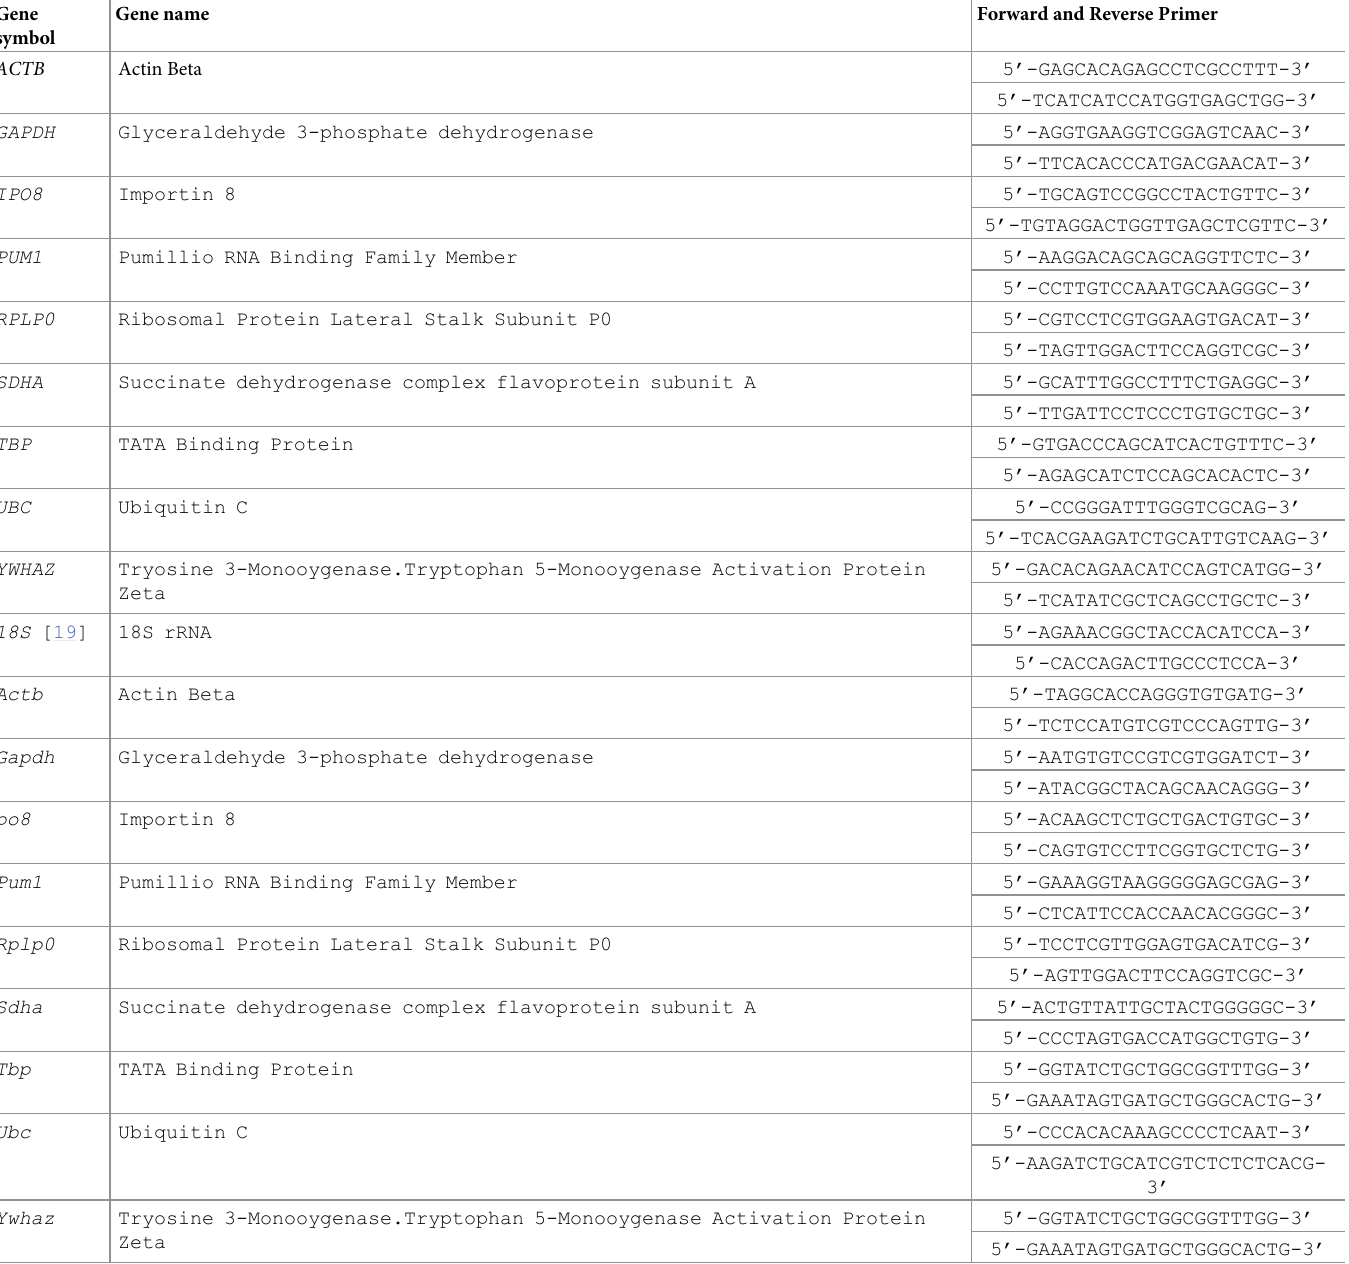
Table 1. Candidate qPCR reference gene names and primer